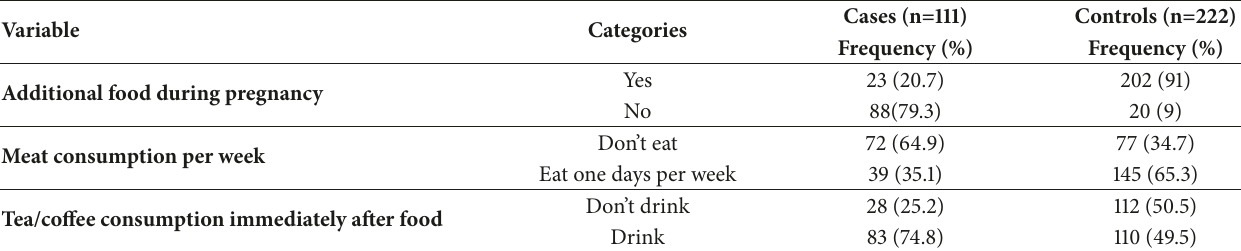
Table 3: Nutritional related characteristics of pregnant mother attending ANC in public health facilities of Durame Town, February to May 2017.